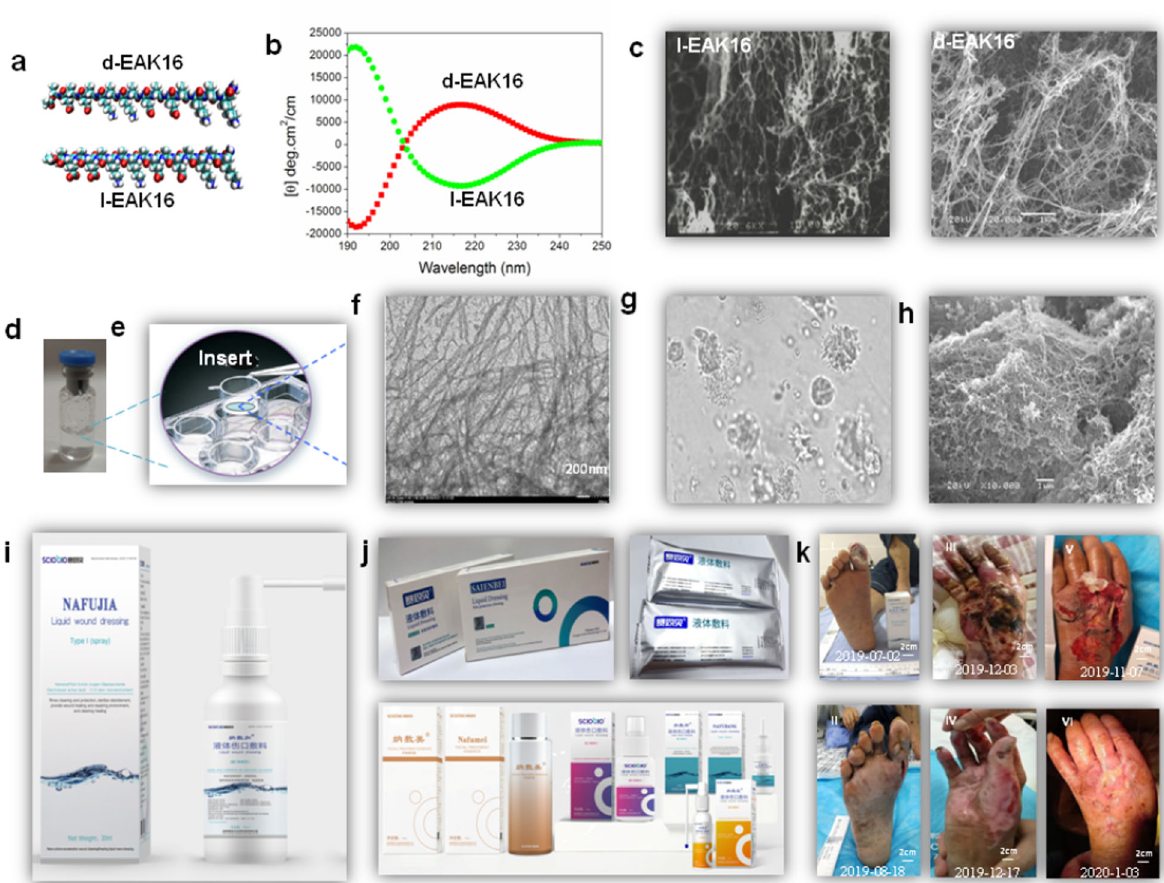
Fig. 4 The chiral self-assembly D- and L-peptide system. a Molecular models of d-EAK16 and l-EAK16. b CD spectra of d-EAK16 and l-EAK16 at 37 °C. c SEM photograph of l-EAK16 and d-EAK16. d The nano fi ber scaffolds of the chiral self-assembling peptide (including Sciobio-II). e The nano fi ber scaffolds used in 3D cell cultures. f The TEM images show the nano fi ber scaffolds. g 3D cell culture as an ECM viewed by microscope. h SEM image of surface of cells covered by enclosed nano fi bers. i Sciobio ® commercial products sold as pre fi lled, sterile chiral self- assembling peptides to hydrocolloid solution as Sciobio liquid wound dressing, used in cleaning, washing, and protecting super fi cial wounds, abrasions in the super fi cial dermis. It forms a protective layer and acts as 3D nano fi ber scaffold with microenvironment to promote wound healing. j Other chiral self-assembling peptides (Sciobio ® , Saienbei, Nafumei, Nafujia, Nafubao, Nafubang) as cosmetics, facial mask, moisturizing lotion, eye cream, and tonic, or used in wound healing, tissue regeneration, and tissue cell and stem cell encapsulation. Updated information is available at www.sciobio.com (for images of i and j: reproduced by permission of Chengdu Sciobio Biotech, Co. Ltd, China, Copyright 2020). k The result to use Nafujia wound liquid dressing treat patients with chronic diabetic foot ulcer (I, before treatment, II, 47 days after, treated by Dr. Xia Yuping, international stoma therapist of vascular surgery, the First People ’ s Hospital, Yibin city, China); use Saienbei liquid dressing treat patients with deep second degree burn (III, before treatment, IV, 14 days after, treated by Dr. Zeng